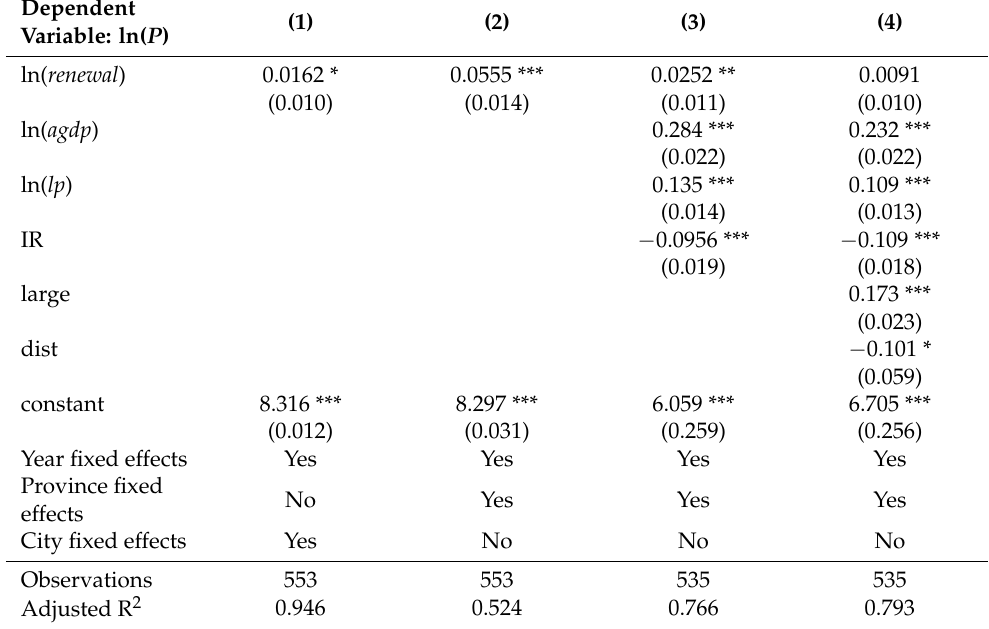
Table 3. Baseline estimation